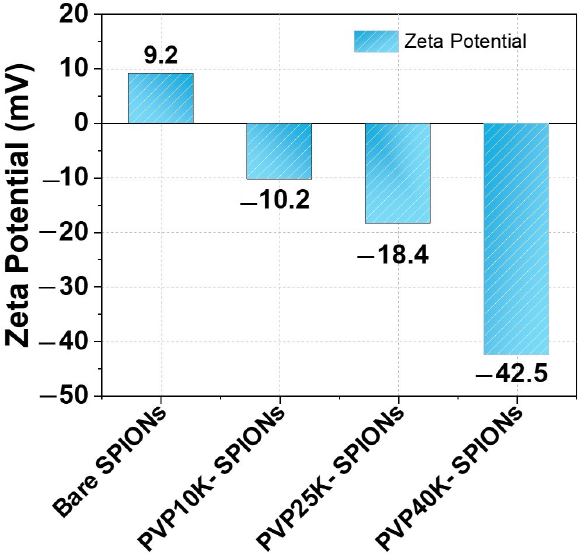
Figure 4. Graphical representation of zeta potential values for bare SPIONs and coated SPIONs.